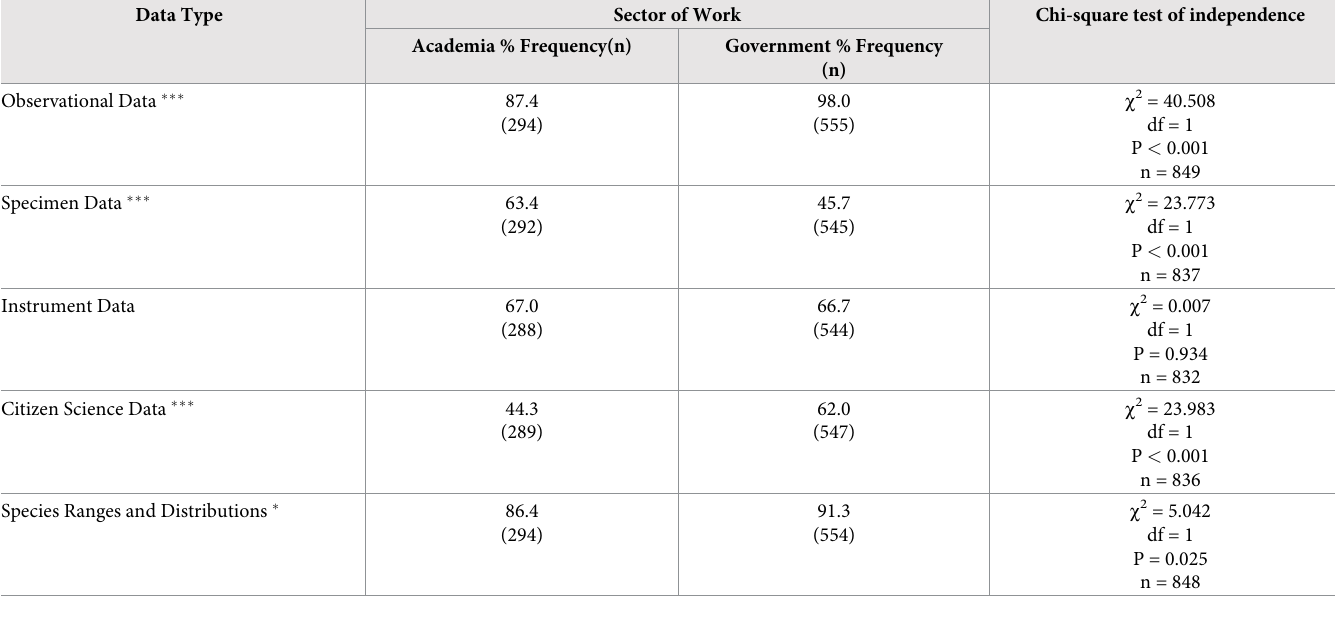
Table 6. Frequency of use of different types of species occurrence